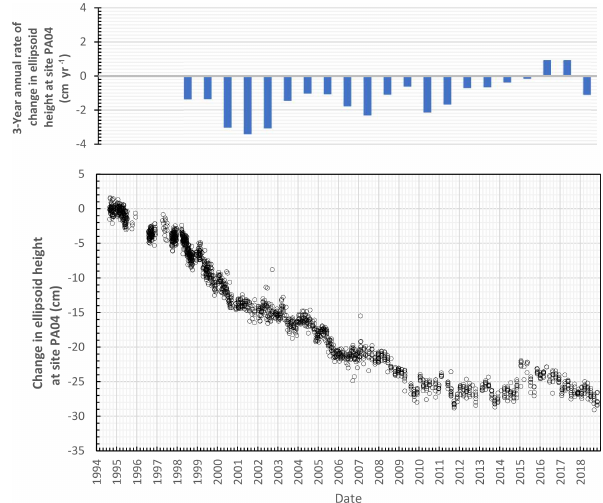
Figure 3. Measured and estimated annual rate of change in el- lisoid height at Harris-Galveston Subsidence District monitoring site PA04 located near Memorial Village, TX, 1994–2019.